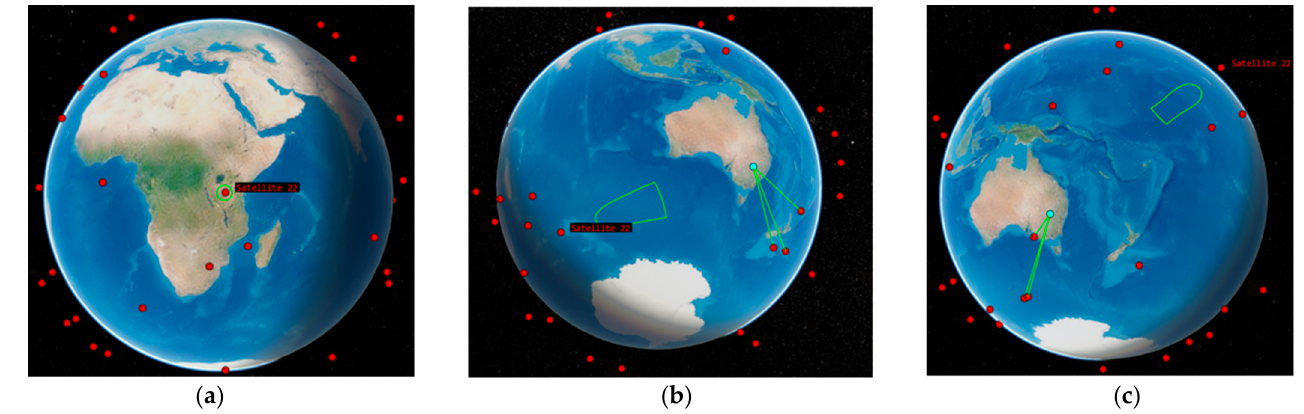
Figure 9. Satellite Field of View: ( a ) nadir pointing; ( b ) reconfiguration at the entry; ( c ) reconfiguration at the exit [35] .